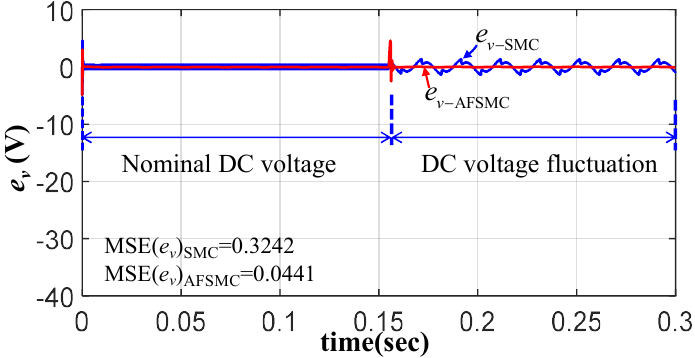
Figure 6. Simulated result of voltage tracking errors under DC voltage fluctuation from 400 V to 380 V.